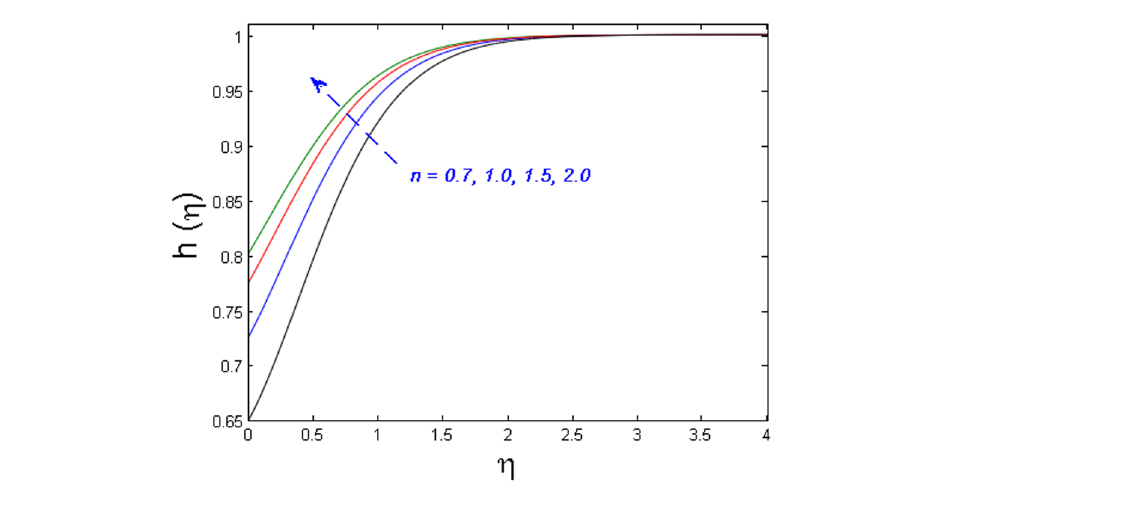
Figure 14. Effect of n on h ( η ).